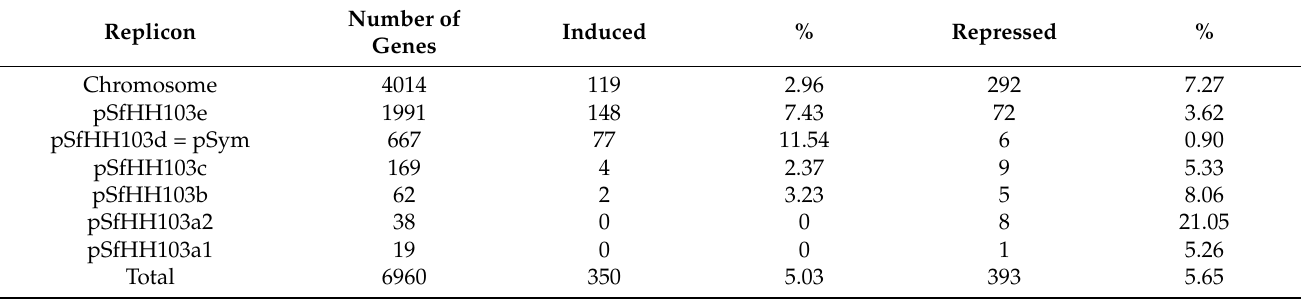
Table 2. Distribution of S. fredii HH103 DEGs in the presence of 400 mM mannitol among the different replicons in the genome.